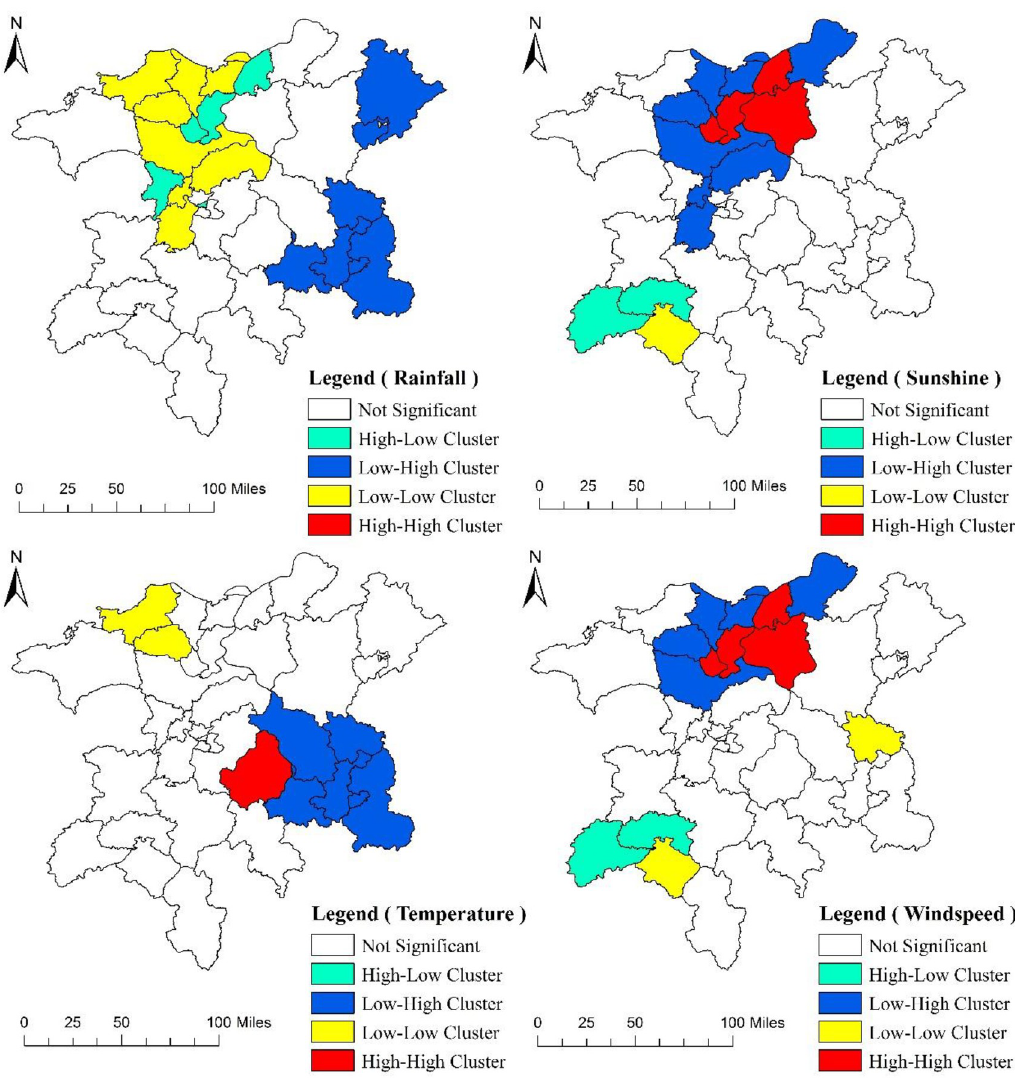
Fig 4. LISA cluster map of population density and climatic